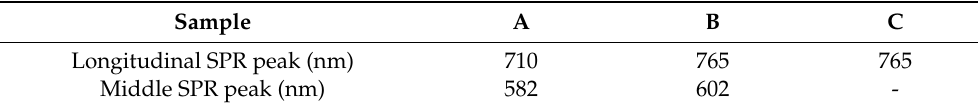
Table 1. Optical properties of the studied anisotropic gold nanostructures.